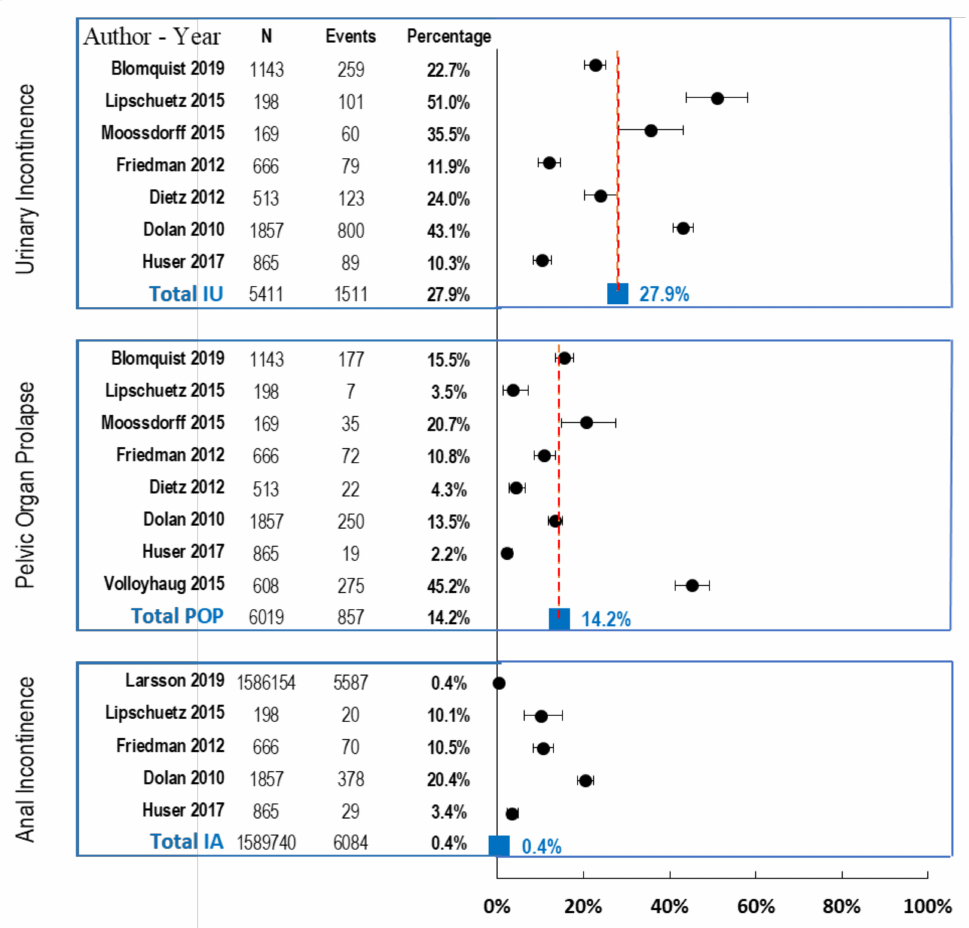
Figure 2. Event case study for Urinary Incontinence (UI), Pelvic Organ Prolapse (POP), Anal Incontinence (AI). OBS = N patients in each study, CI Confidence Interval and Forest